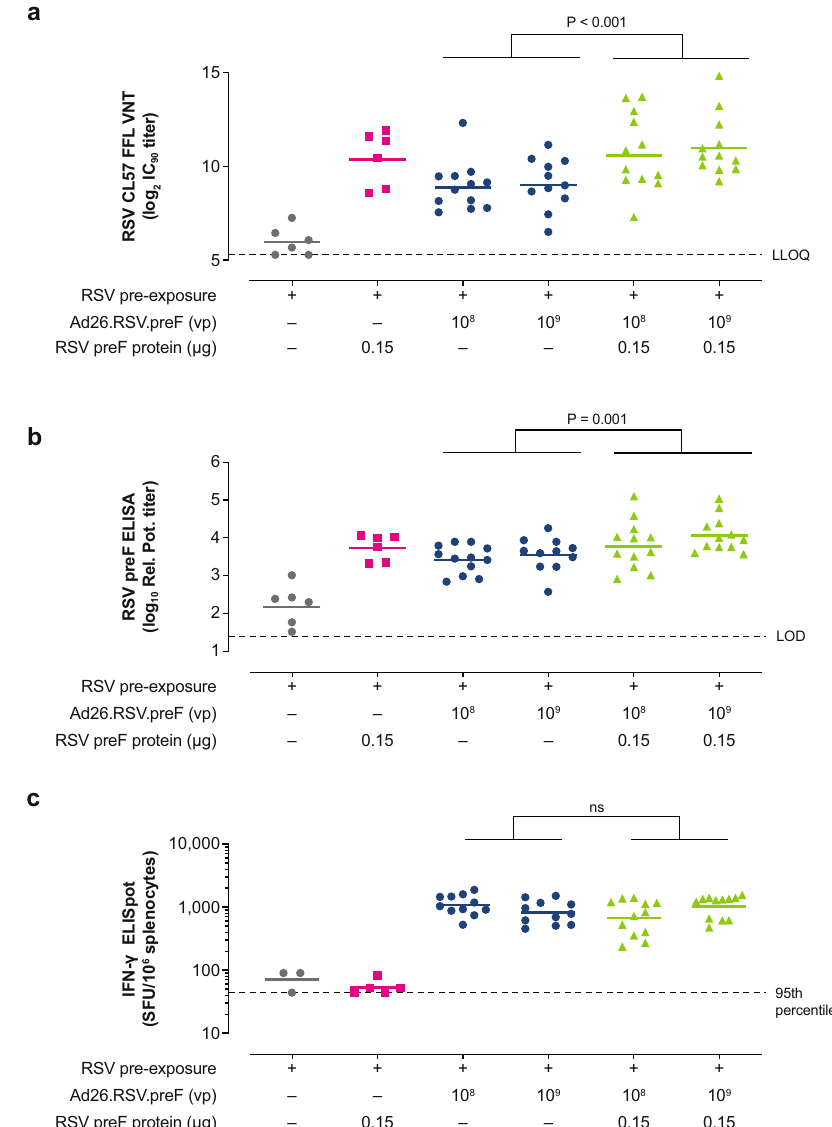
Fig. 3 Humoral and cellular immunogenicity in RSV pre-exposed mice. Naïve female BALB/c mice were intranasally pre-exposed with RSV A2 (5 × 10 5 pfu) at Week – 79 and immunized intramuscularly at Week 0 with Ad26.RSV.preF (1 × 10 8 or 1 × 10 9 vp; n = 12 in each group), RSV preF protein (0.15 µg; n = 6), or Ad26.RSV.preF (1 × 10 8 or 1 × 10 9 vp) combined with RSV preF protein (0.15 µg; n = 12 each group). Negative control animals received formulation buffer ( n = 6). VNT against RSV CL57, expressed as log 2 IC 90 titers, were measured in serum at Week 5 ( a ). Horizontal bars indicate mean VNT per group, and the dotted line indicates the LLOQ. RSV preF total IgG-binding antibody titers ( b ), expressed as log 10 relative potency titers, were also measured in serum at Week 5. Horizontal bars indicate mean titers per group, and the dotted line indicates the LOD. Cellular responses were measured by IFN- γ ELISpot in splenocytes at Week 5 ( c ), and the responses are expressed as SFU per million splenocytes. The horizontal lines indicate the geometric mean response per group, and the dotted line indicates the 95th percentile of the response of unstimulated cells. Statistical comparisons were made across Ad26.RSV.preF dose by ANOVA for potentially censored measurements (Tobit model) with Bonferroni correction for multiple comparisons (at an overall signi fi cance level of α = 0.05). Ad26, adenovirus type 26; ELISA, enzyme-linked immunosorbent assay; ELISpot, enzyme-linked immune absorbent spot; FFL, fi re fl y luciferase; IC 90 , 90% inhibitory concentration; IFN- γ , interferon- γ ; IgG, immunoglobulin G; LLOQ, lower limit of quanti fi cation; LOD, limit of detection; ns, not signi fi cant; pfu, plaque-forming units; preF, prefusion conformation-stabilized RSV F protein; Rel. Pot., relative potency;